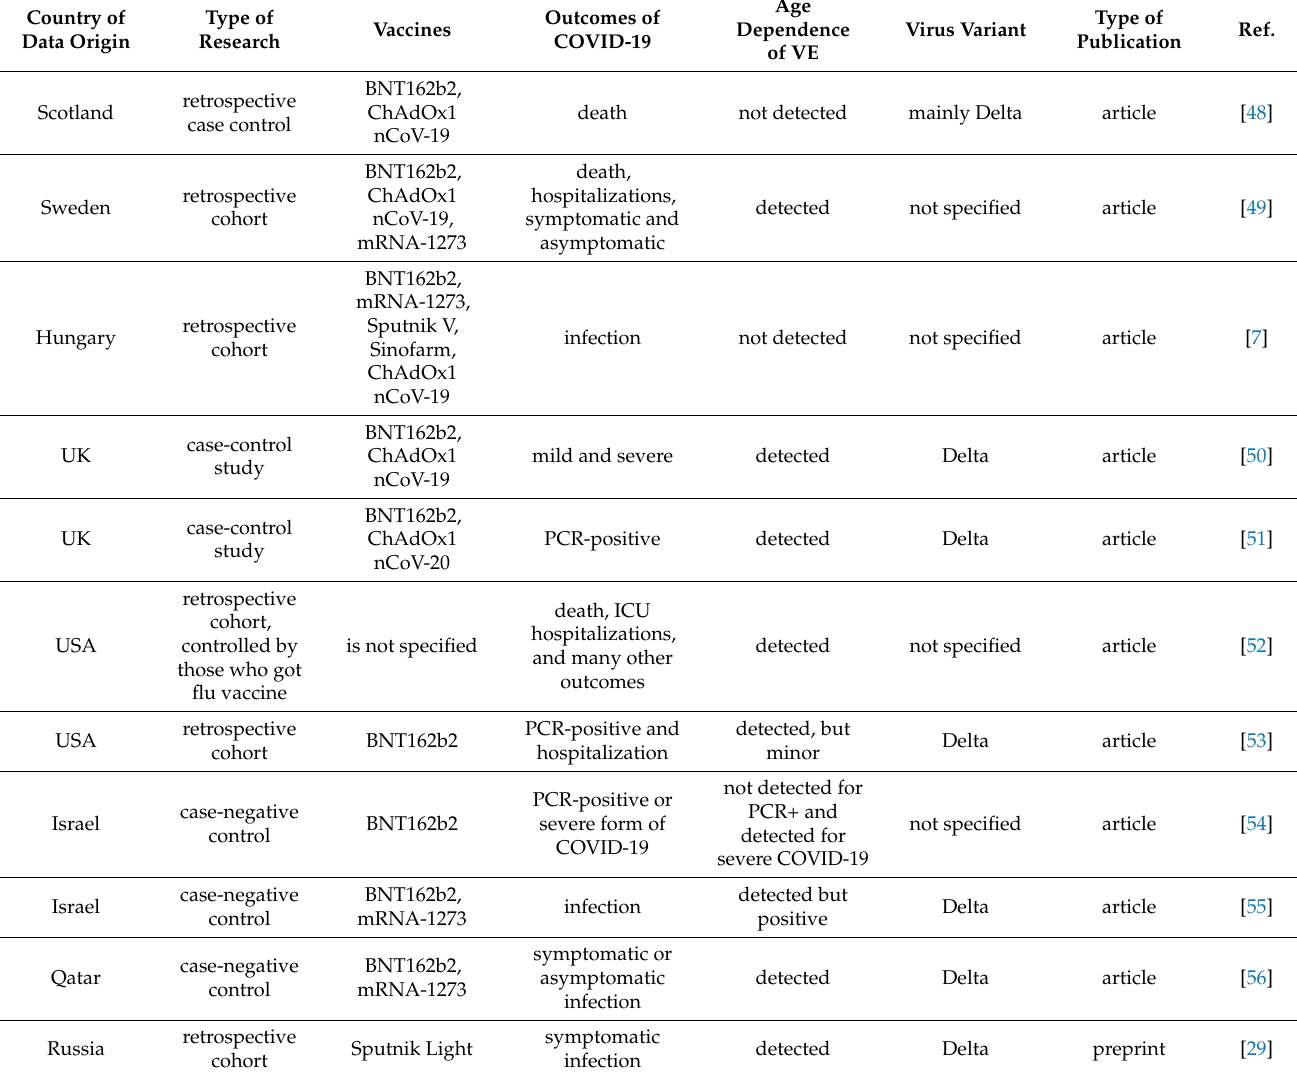
Table 3. Studies demonstrating the negative correlation between VE and